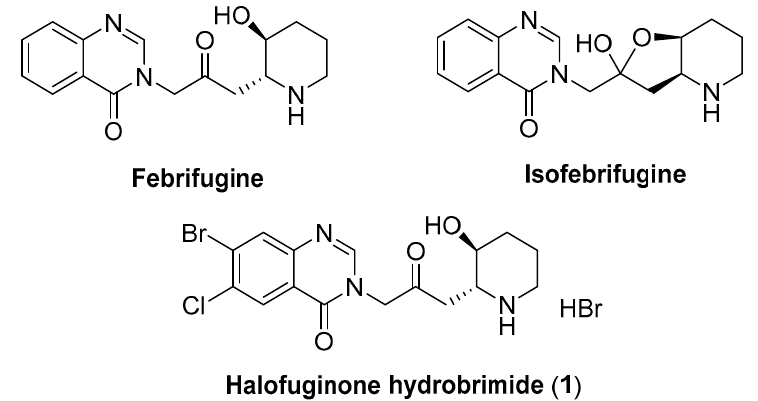
Figure 1. Structures of febrifugine, isofebrifugine, and halofuginone hydrobrimide ( 1 ).